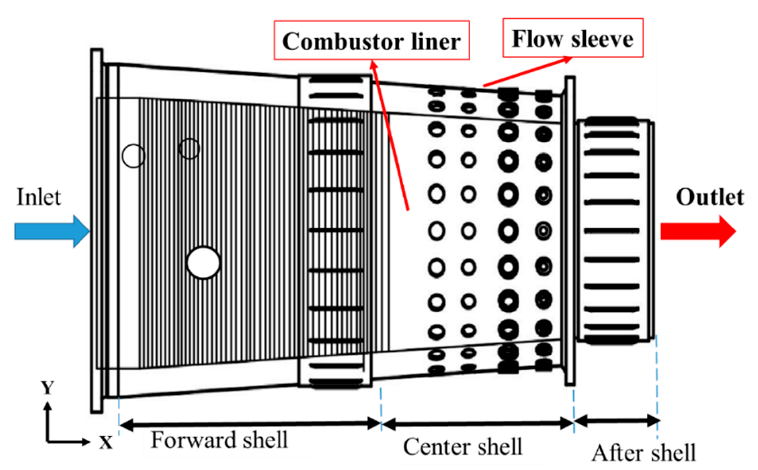
Figure 1. Schematic sketch of a low-NO X premixed combustor.